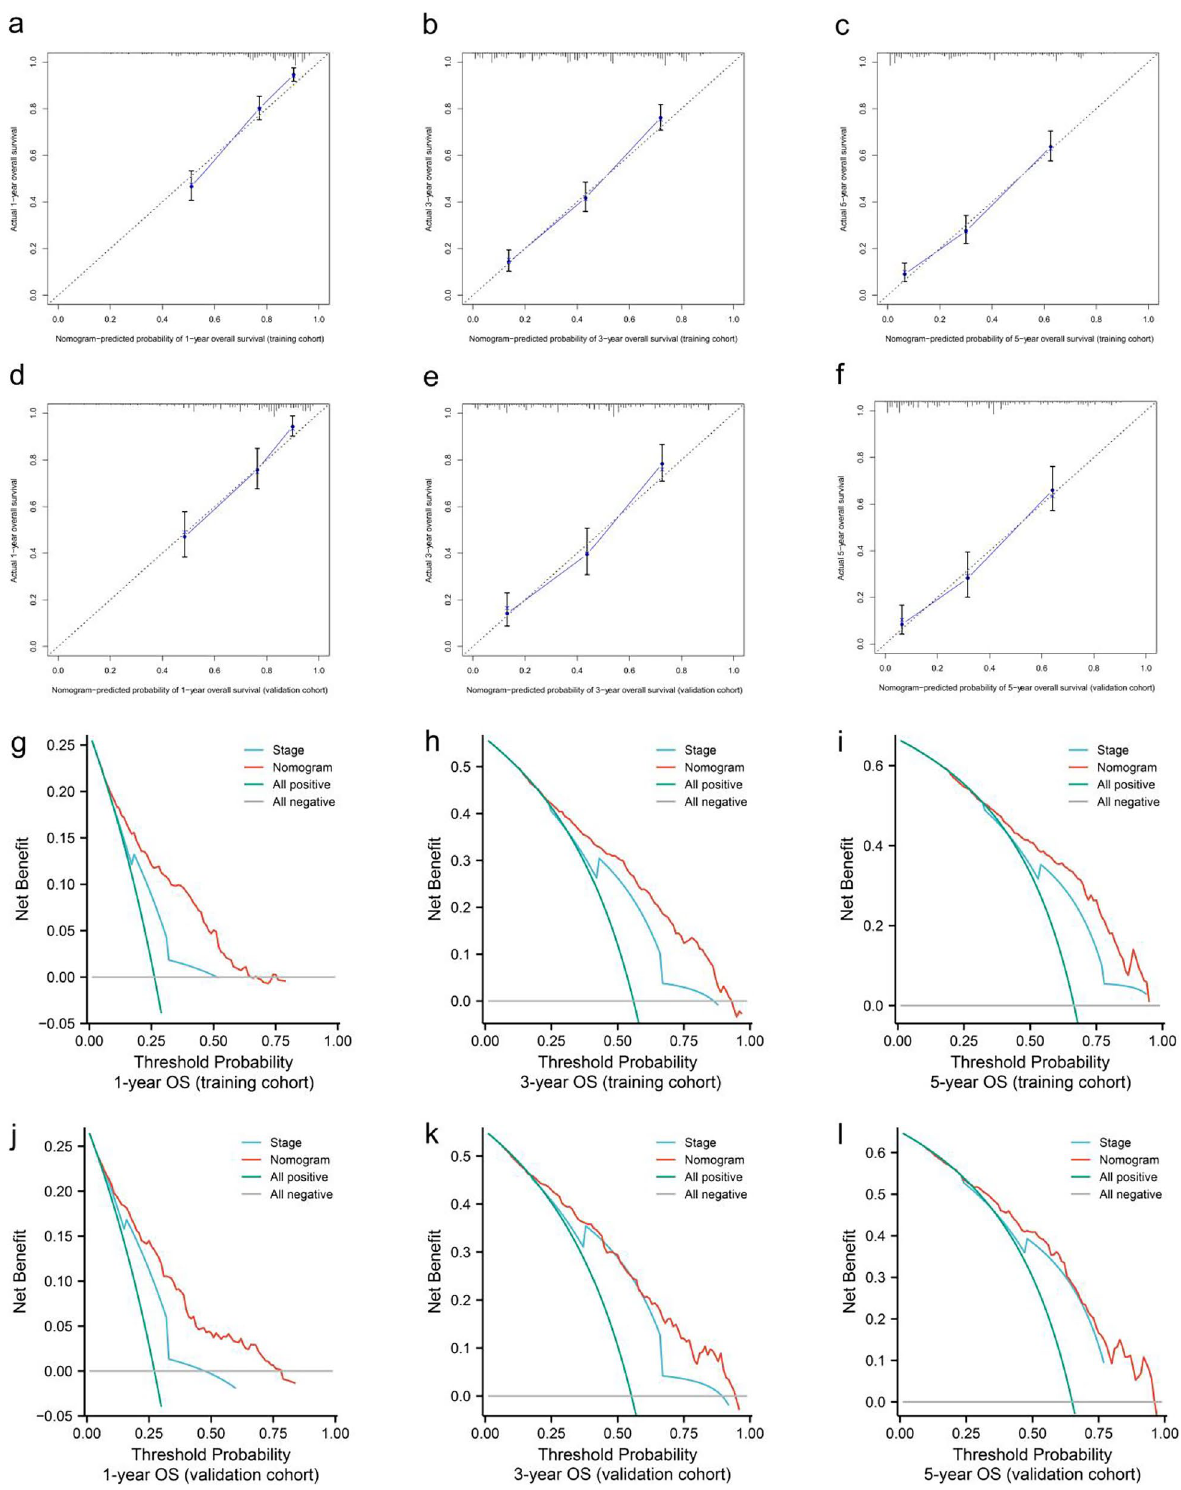
Figure 3. Calibration curves and decision curve analysis of the nomogram for the survival prediction of patients with NM-GBA. ( a–f ) Calibration curves of 1-year, 3-year, and 5-year OS in the training and validation cohorts. ( g–l ) 1-year, 3-year, and 5-year survival benefit of in the training and validation cohorts. NM-GBA non- metastatic gallbladder adenocarcinoma, OS overall